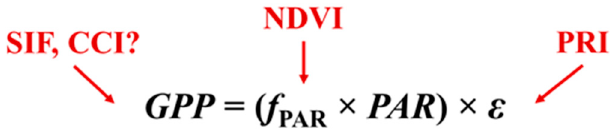
Figure 1. Representation of the light-use efficiency (LUE) model in black, stating that gross primary productivity (GPP) is a function of absorbed photosynthetically active radiation (APAR: f PAR × PAR) and efficiency ( ε ). Red text shows optical measurements useful for model parameterization and validation, including solar-induced fluorescence (SIF), the chlorophyll/carotenoid index (CCI), the normalized difference vegetation index (NDVI), and the photochemical reflectance index (PRI) (modified from Gamon 2015) [31].